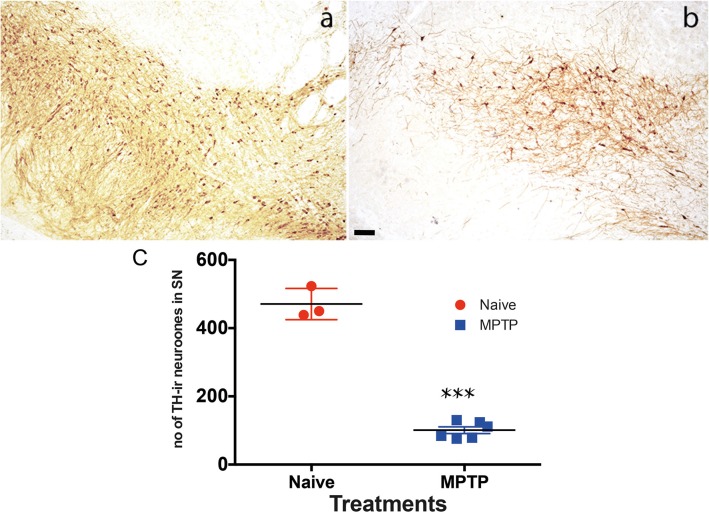
Tyrosine hydroxylase immunoreactivity in the substantia nigra (SN) of normal (a) and MPTP-treated common marmosets.TH-immunoreactive neurones in normal, drug naive (a) and MPTP-treated (b) substantia nigra were significantly reduced at the level of 3rd cranial nerve following MPTP treatment. Each data point represents mean ± sem (n = 7) ***P<0.001(c). The scale bar represents 200 μm.